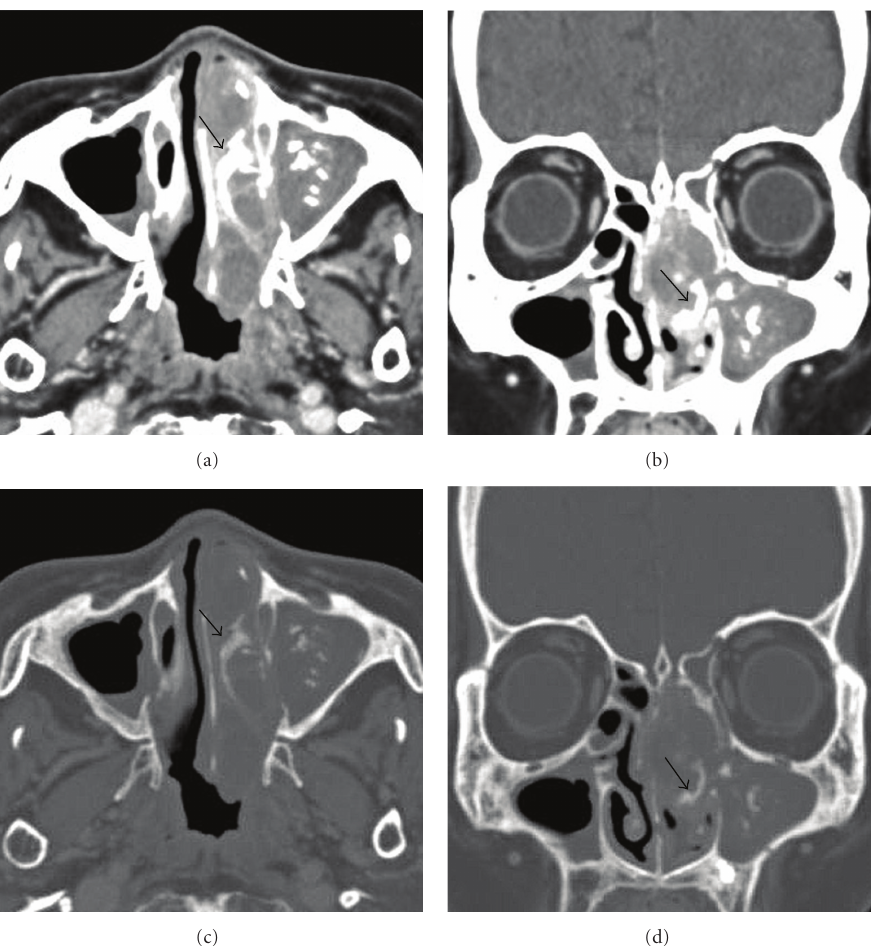
Figure 1: Horizontal (a) and axial (b) enhanced computed tomography (CT) showed an inhomogeneously enhancing mass that filled the left nasal cavity. A low-density lesion with metal-dense spots in the left maxillary sinus, indicating mycetoma, was also observed. Bone window images ((c), (d)) also showed a new bone formation in the tumor. Black arrows indicate a new bone formation.